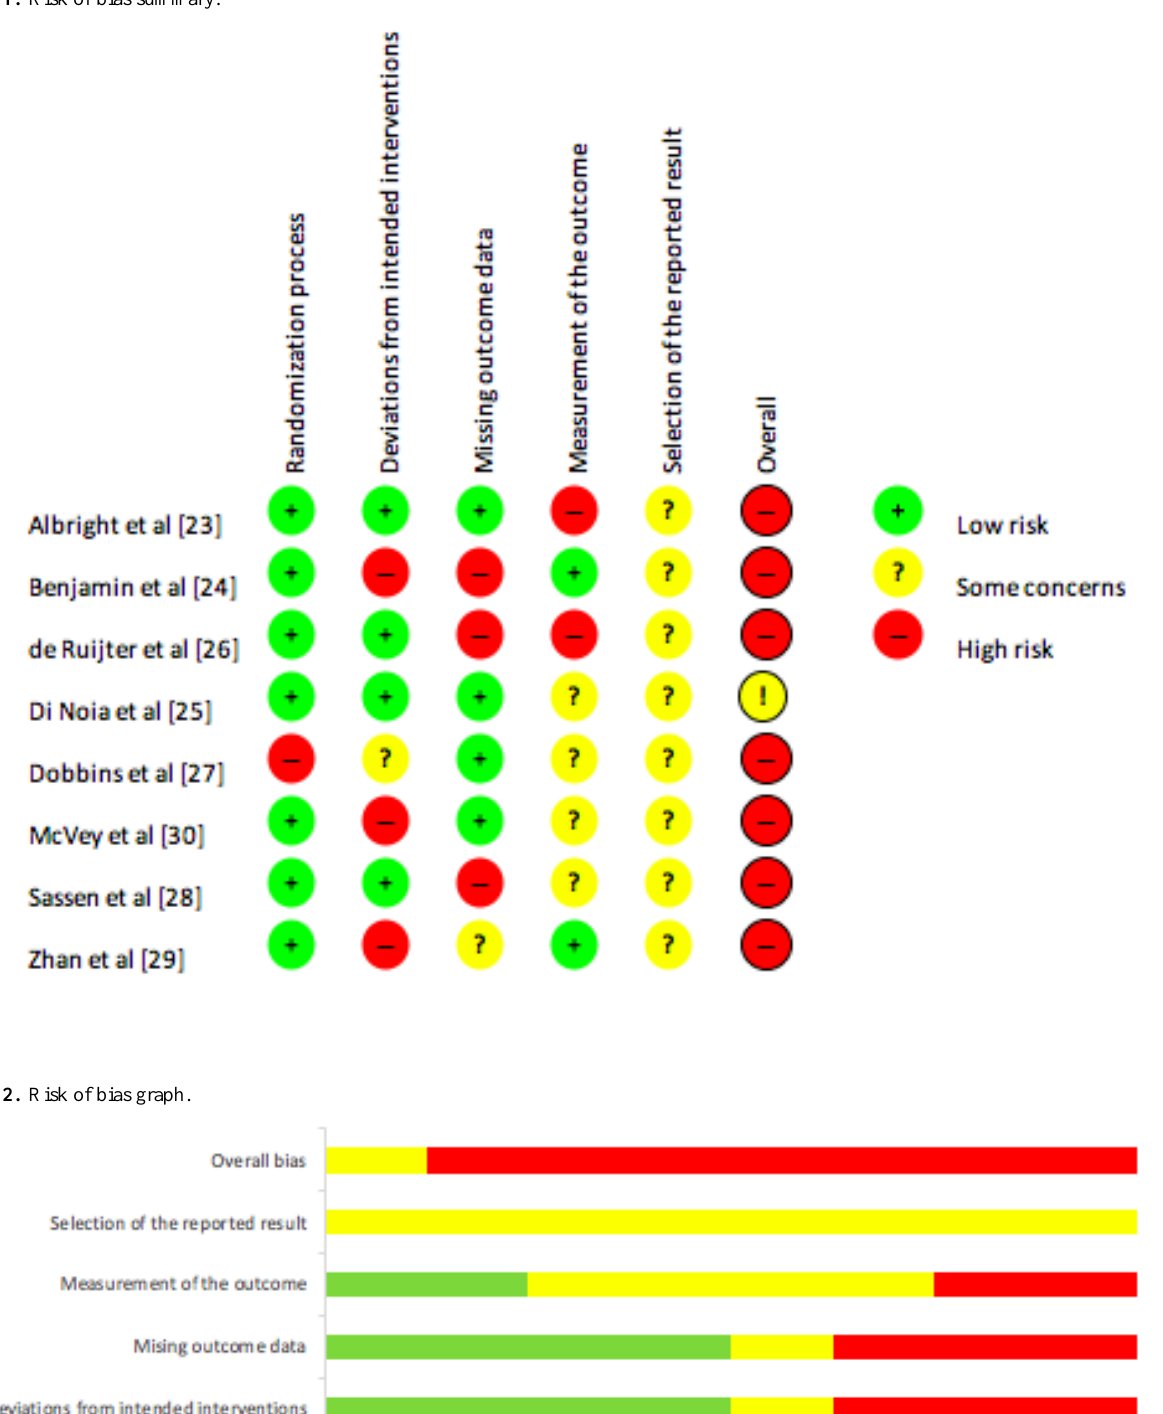
Figure 1. Risk of bias summary.